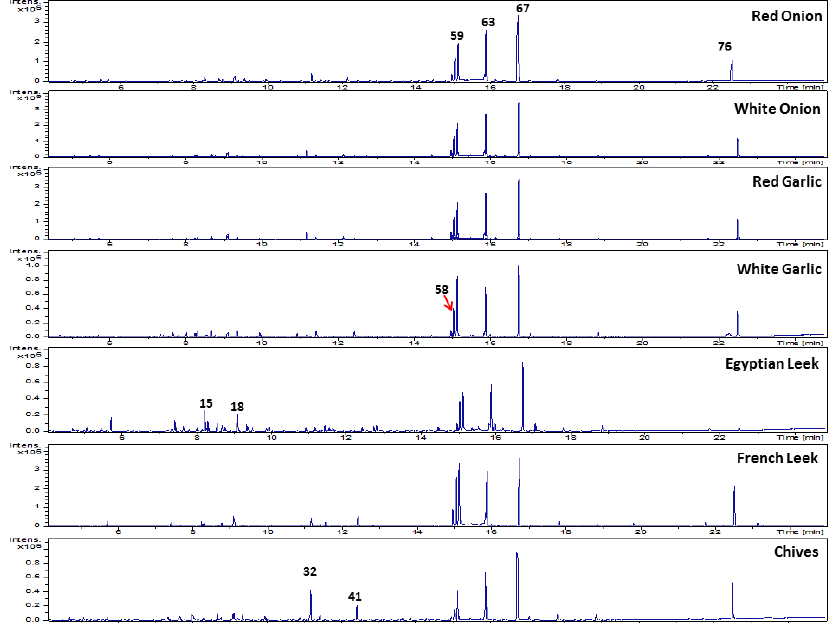
Figure 1. Representative GC–MS chromatograms of primary metabolites were identified in seven Allium species post-silylation. The corresponding compound names for numbered peaks follow those listed in Table 1: 15, L-Leucine; 18, Glyceric acid; 32, Malic acid; 41, D-Psicose; 58, D-Tagato- furanose; 59, D-Fructopyranose; 63, D-Manopyranose; 67, D-Glucopyranose; 76, Sucrose.